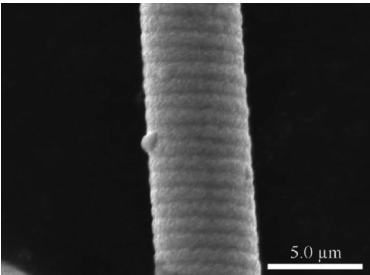
Figure 23. SEM image of a Ni–P coated CMC [65]. Reprinted with permission from [65], Copyright 2009